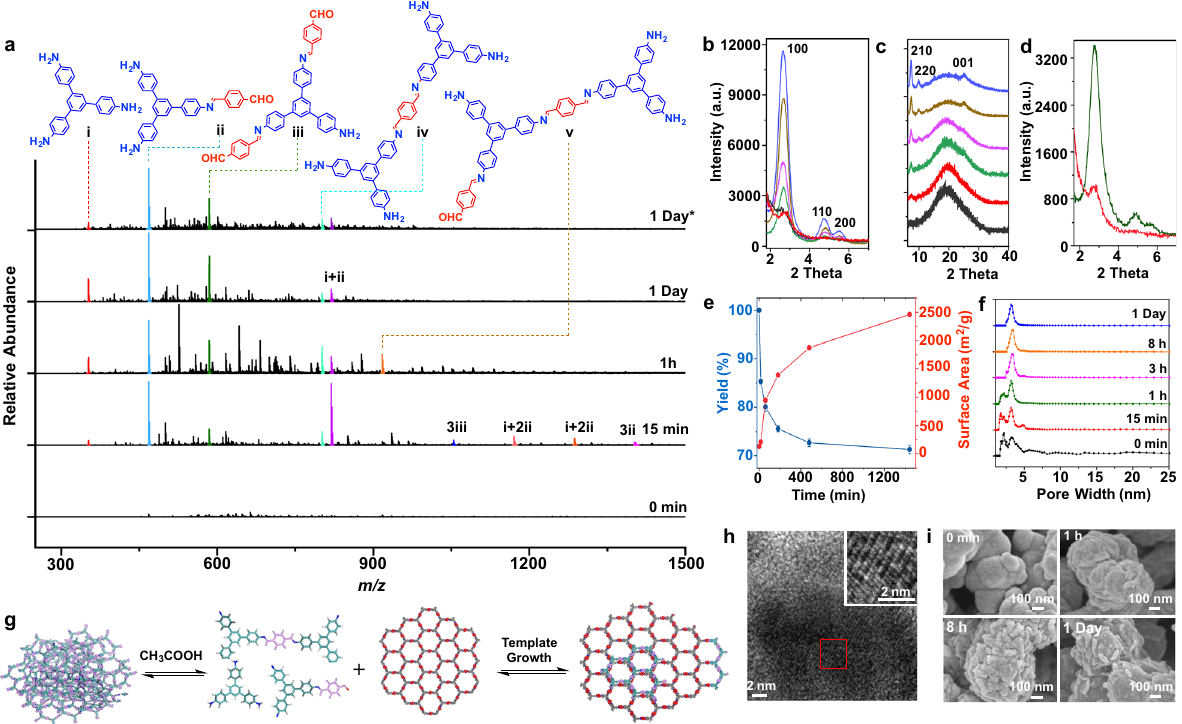
Fig. 3 Self-healing growth of TAPB-TA COF. a MS characterization of the molecular species in self-healing solution with different reaction time; *mass spectrum from TAPB-TA nucleation growth solution. Quantitative PXRD patterns of TAPB-TA with different self-healing time, 2 θ value ranging from ( b ) 1.8° to 7.0°, and ( c ) 7.0° to 40°; growth time: 0 min (black), 15 min (red), 1 h (green), 3 h (purple), 8 h (orange), and 1 day (blue). d Quantitative PXRD patterns of TAPB-TA with 15 min growth time (green) and 15 min self-healing time (red). e Yield and surface area of TAPB-TA COF versus growth time. f Pore size distribution of the TAPB-TA COF with different self-healing time. g Proposed TAPB-TA COF self-healing mechanism. h TEM image of TAPB. i SEM images of TAPB-TA COF with different self-healing